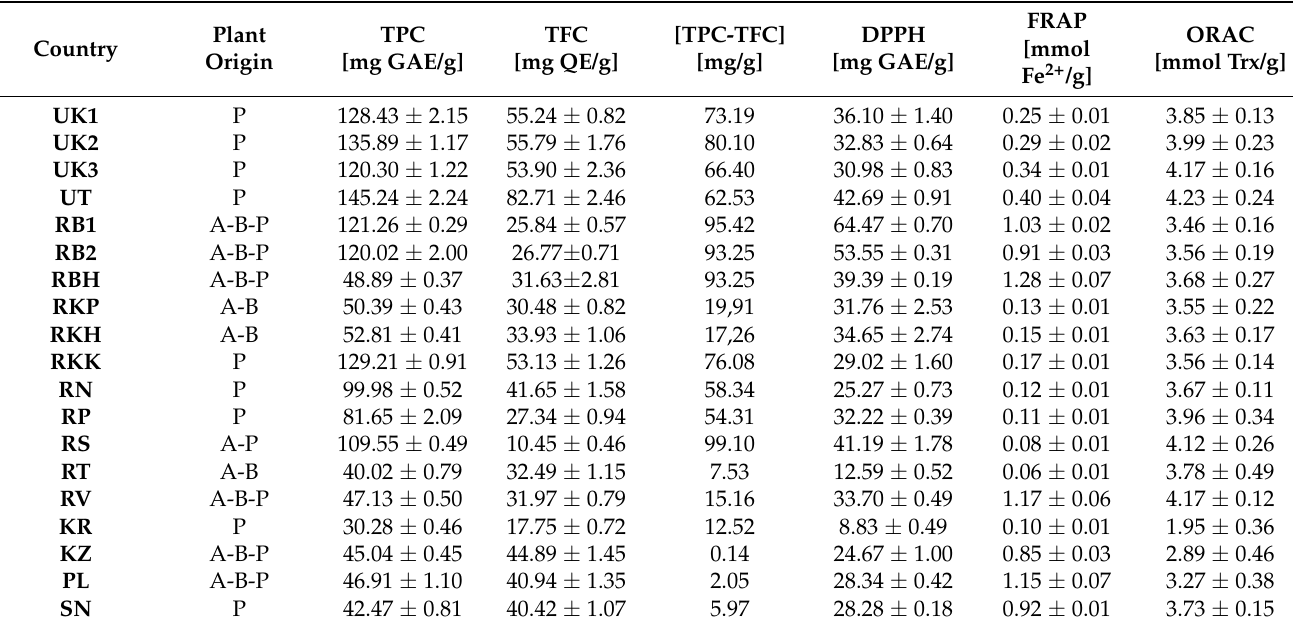
Table 3. Colorimetric evaluation of Eurasian